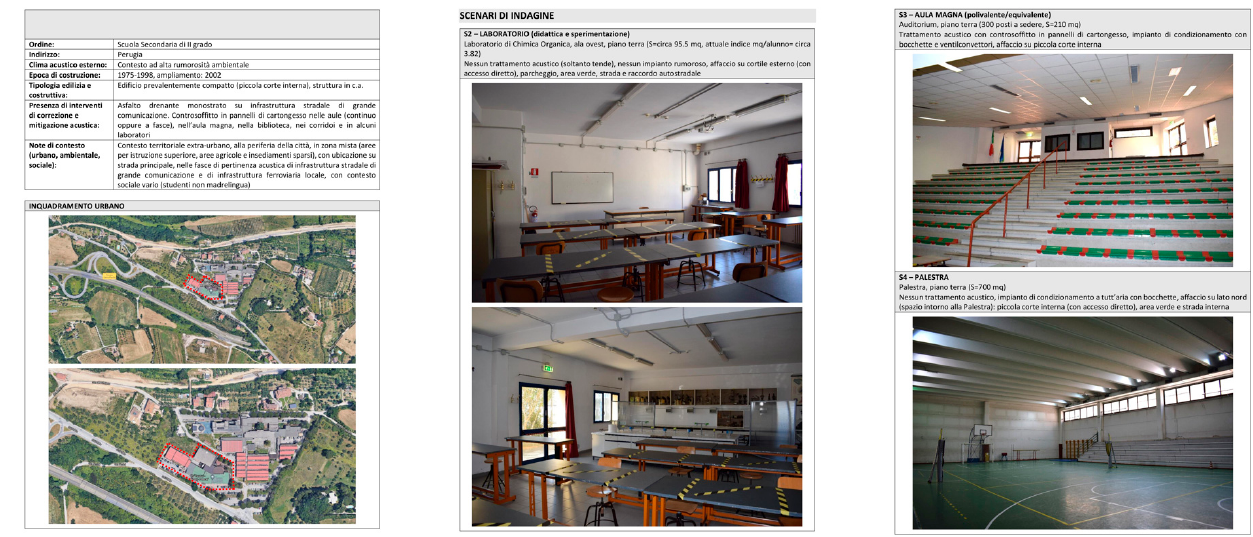
Figure 1. An extract from the descriptive sheets of a school.